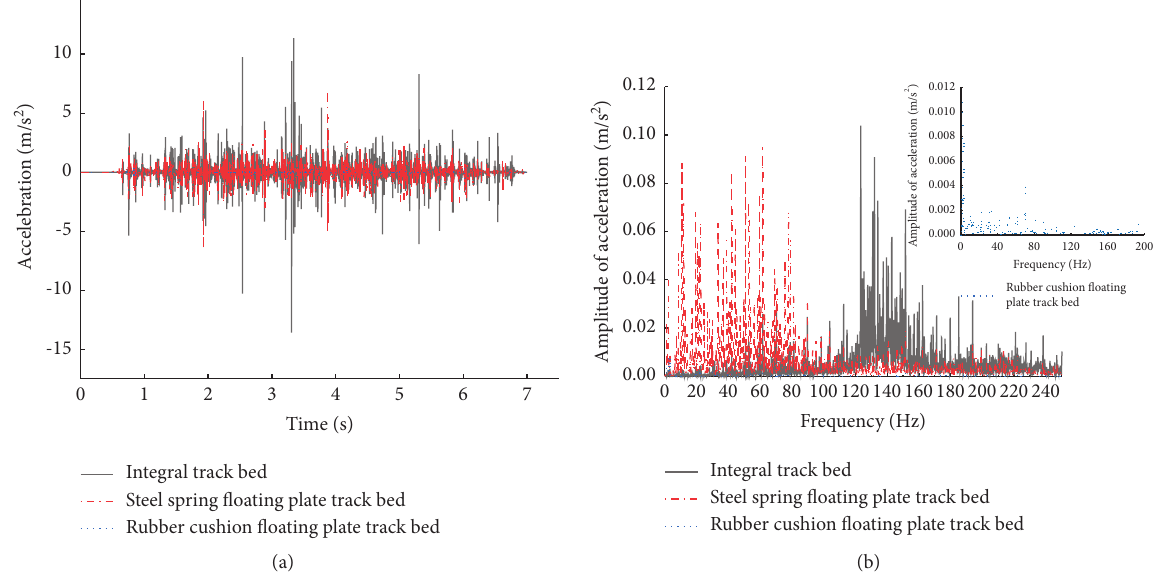
Figure 14: Acceleration (a) time-history curve and (b) amplitude-frequency curve under different trackbed forms.